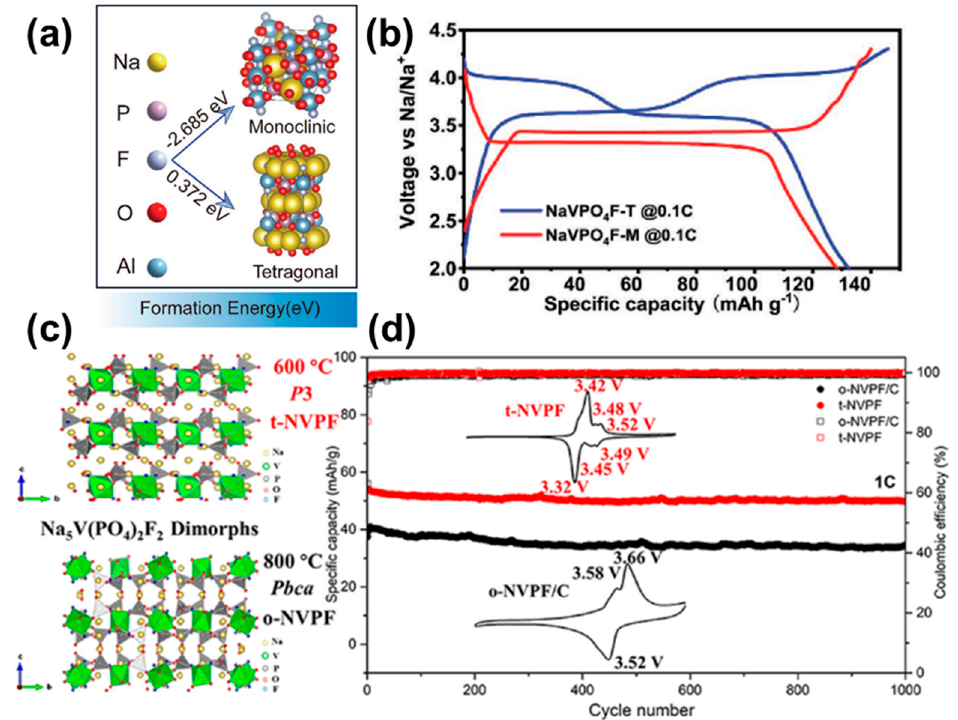
Figure 4. ( a ) The formation energy calculated by DFT methods and ( b ) galvanostatic charge/dis- charge curves at 0.1C of NaVPO 4 F-M and NaVPO 4 F-T [79]. ( c ) The crystal structure and ( d ) cyclability, as well as CV curves, of o-Na 5 V(PO 4 ) 2 F 2 /C and t-Na 5 V(PO 4 ) 2 F 2 [35].